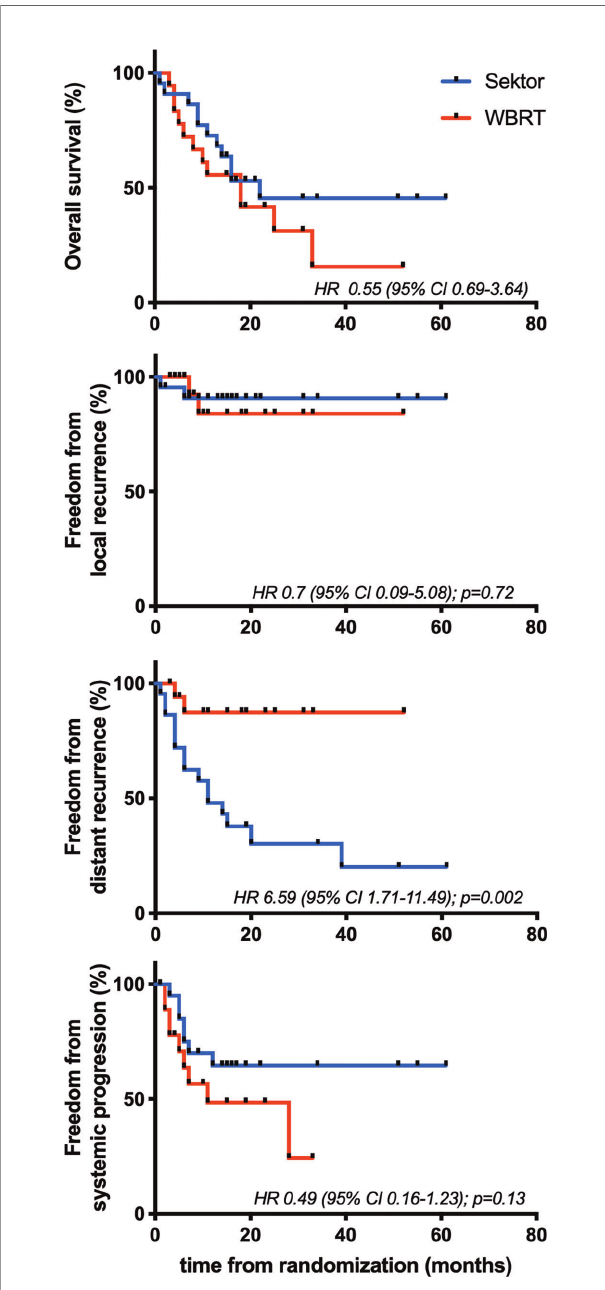
FIGURE 2 | Kaplan-Meier estimates of overall survival, freedom form local and distant recurrence and systemic